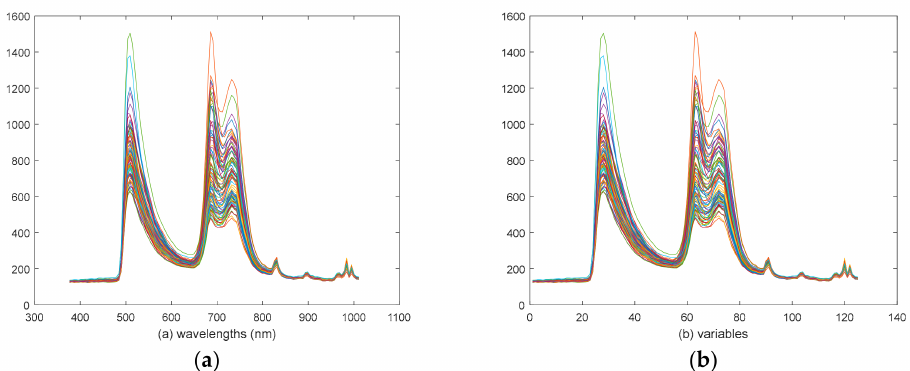
Figure 4. Raw hyperspectral fluorescent images: ( a ) wavelengths (nm), ( b )